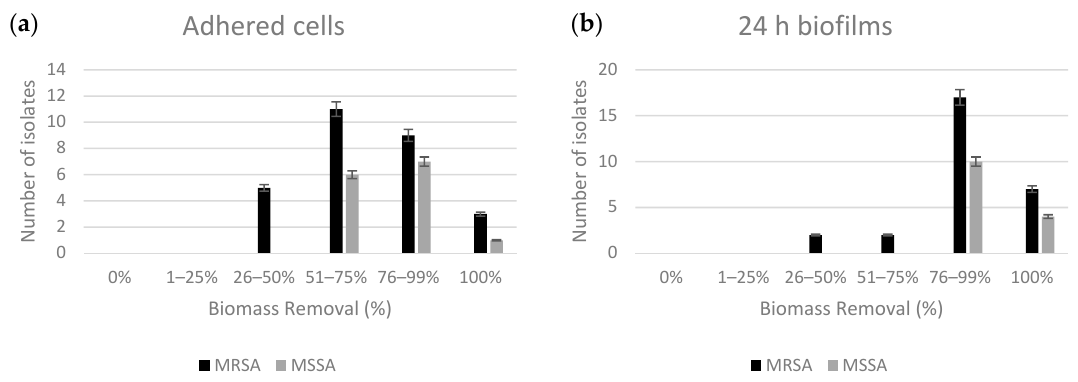
Figure 2. Percentage of biomass removal of ozonated oils at MIC value on ( a ) adhered cells and ( b ) 24 h old biofilms of 28 MRSA (black) and 10 MSSA (grey) strains.